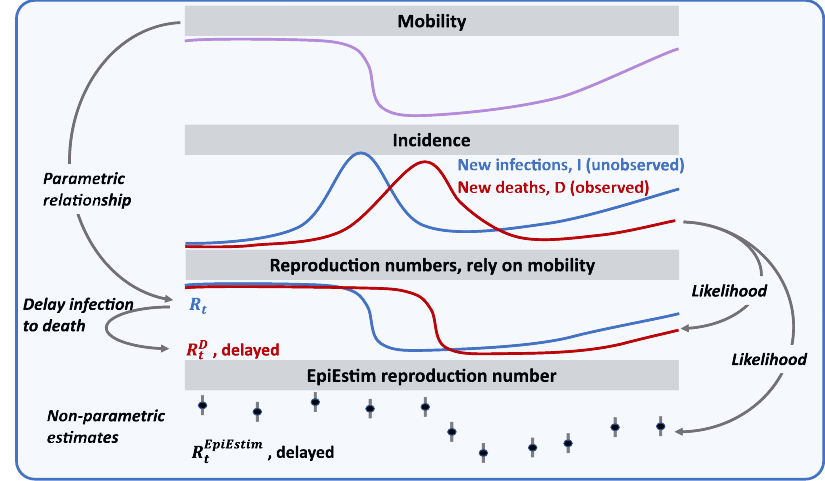
Fig. 1 Schematic of the methodology. A parametric relationship between transmission and mobility is assumed and allows to link the effective reproduction number at time of infection ( R t , i ) to mobility ( m t , i ).We obtain the delayed effective reproduction number at time of death ( R D t ; i ) as a weighted average of R t , i ’ s, relying on the delay between infection and death (see Methods section). Inference relies on the likelihood of observed vs predicted deaths, with predicted deaths being a function the R D t ; i (see Methods section). To estimates how much variations in transmission can be explained by variations in mobility, we estimate a non-parametric and delayed reproduction number relying on EpiEstim framework 23 ( R D ; EpiEstim t ; i ) and compare it to R D t ; i .